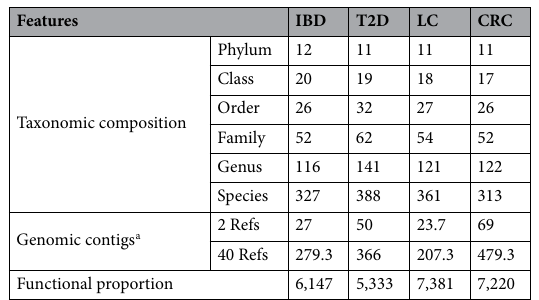
Table 1. Number of input features in the IBD, T2D, and LC datasets. a For genomic features, an average of three runs conducted with different representative samples was calculated.